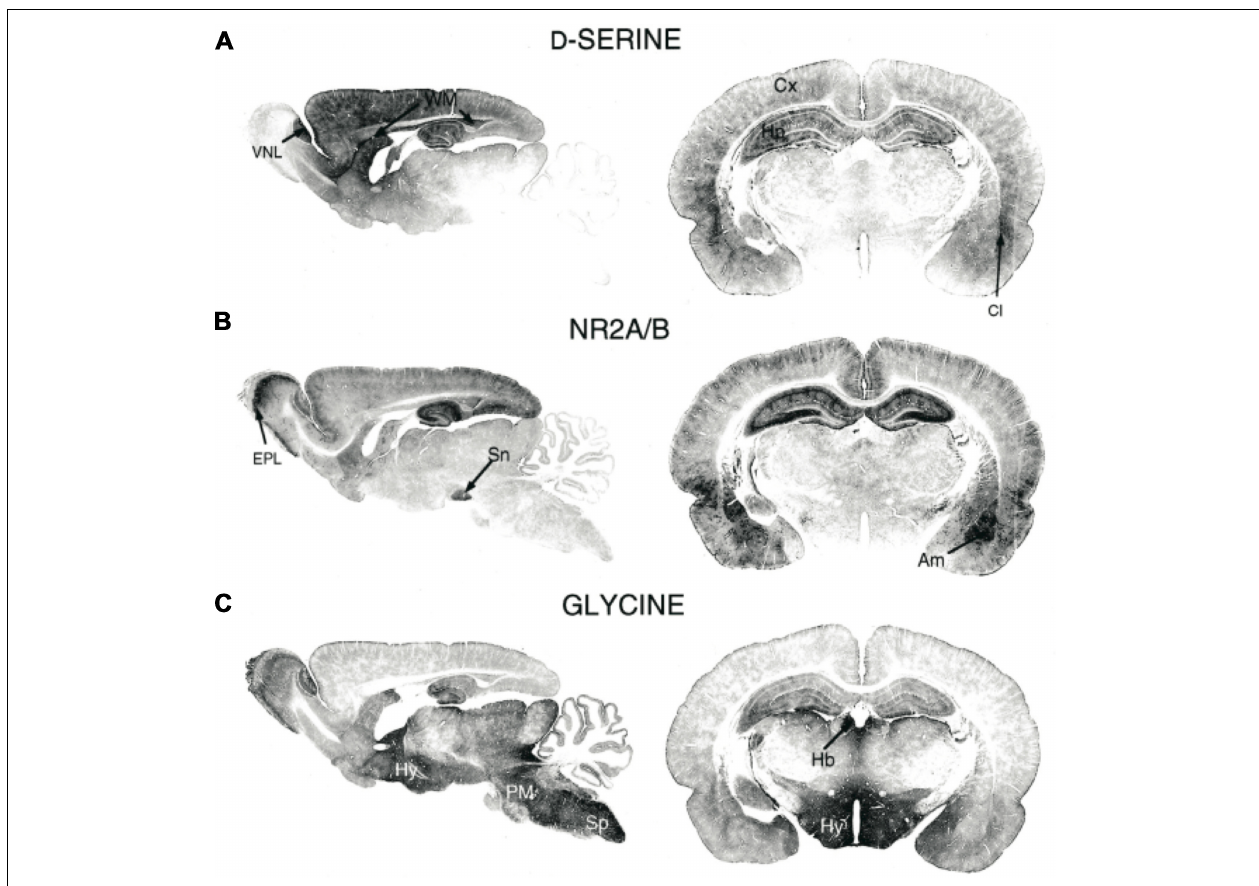
FIGURE 1 | Immunohistochemical staining of (A) D -serine, (B) NMDAR subunits GluN2A/B, and (C) glycine in rat brains (P21). Am, amygdala; Cl, claustrum; Cx, cortex; EPL, external plexiform layer; Hb, habenula; Hy,